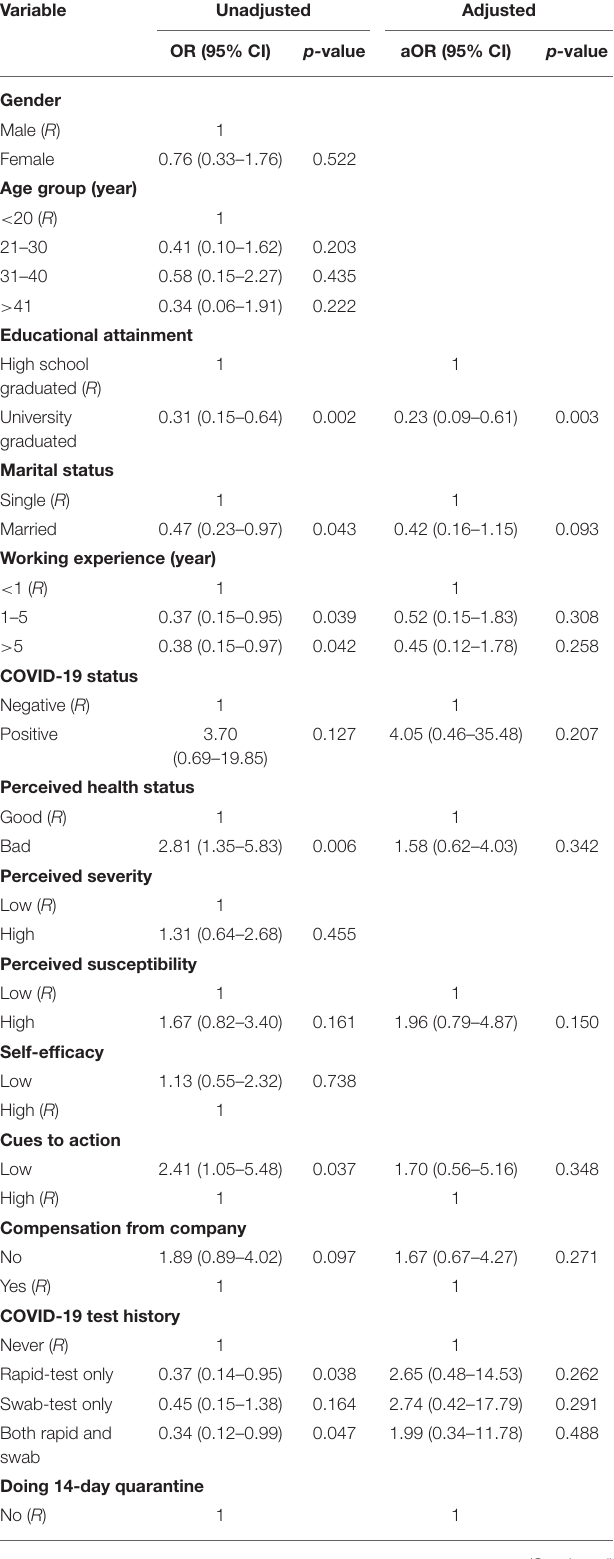
TABLE 4 | Unadjusted and adjusted logistic regression analysis showing factors associated with depression during COVID-19 ( n = 335).